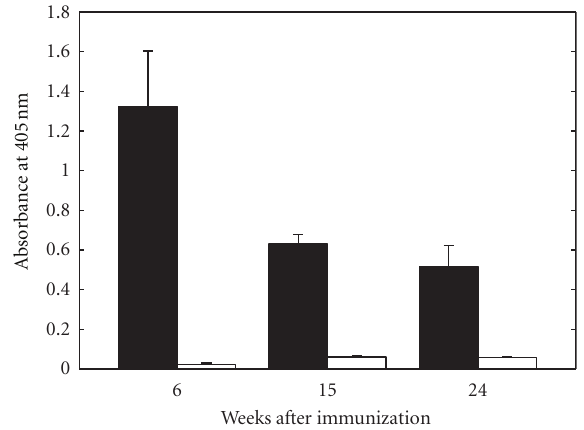
Figure 1: Antibodies to cardiolipin ( β 2 GPI-dependent) in eAPS (black bars) and adjuvant control mice (white bars) sera 6, 15, and 24 weeks after immunization. Results are presented as the mean absorbance values ±